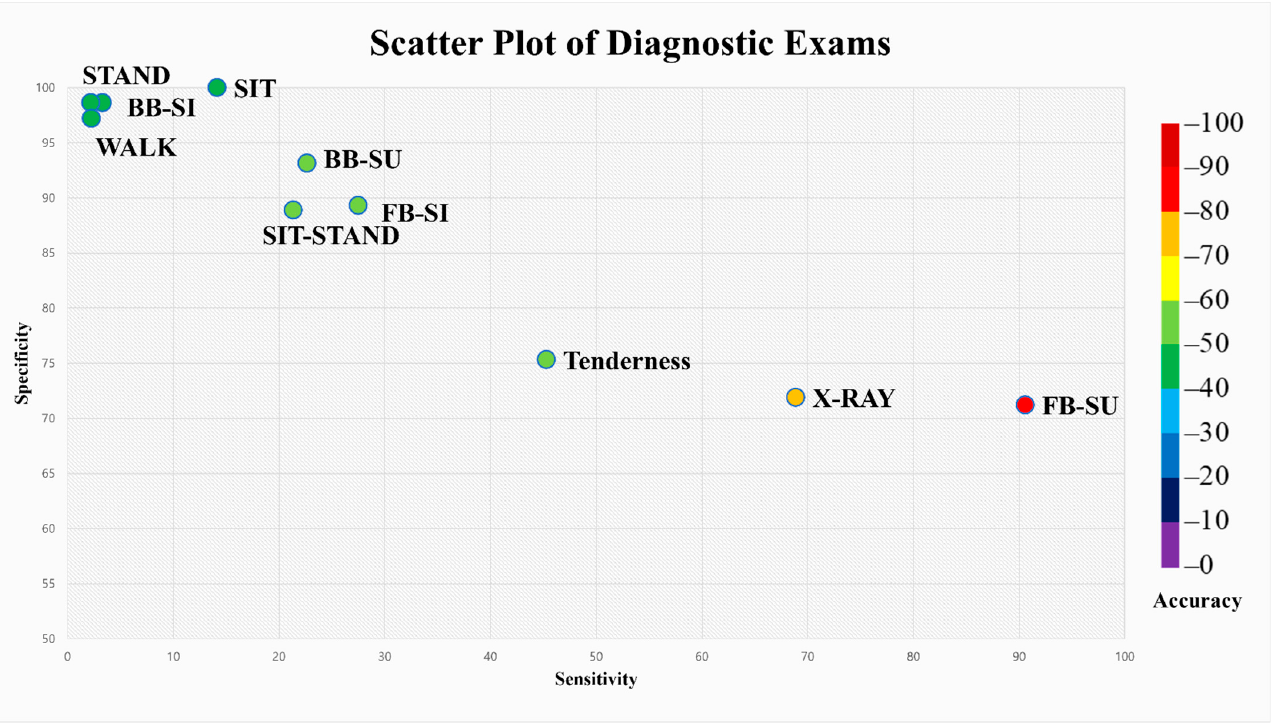
Figure 4. Scatter plot diagram of physical examinations and radiographic interpretations illustrating sensitivity, specificity, and accuracy.